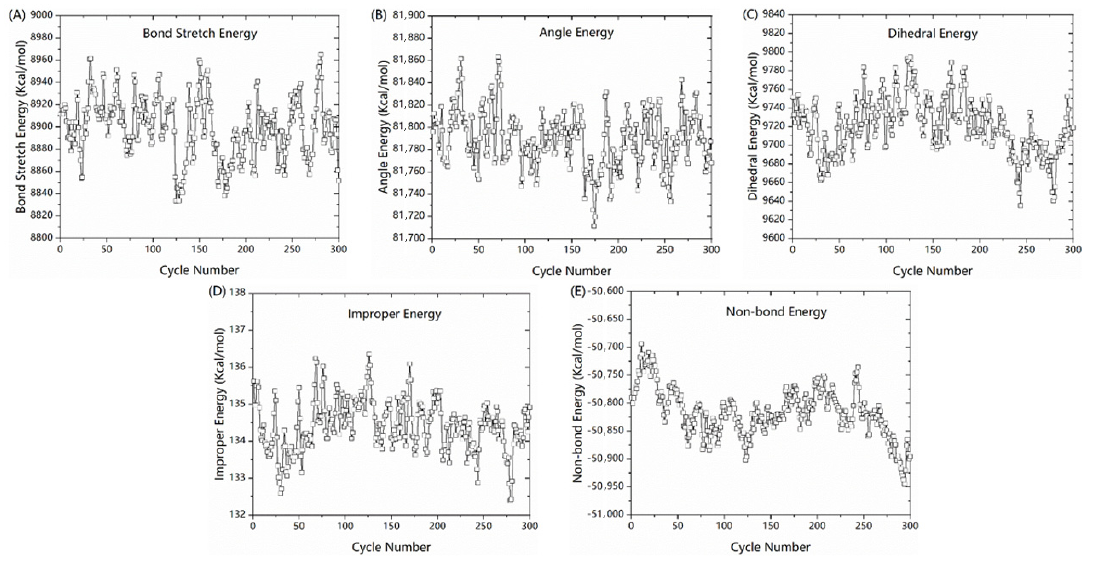
Figure 8. Evolution of individual potential energy in 90 ◦ direction. ( A ) bond stretch energy, ( B ) bond angle energy, ( C ) Figure 8. E volution of individual potential energy in 90° direction. ( A ) bond stretch energy, ( B ) bond angle energy, ( C ) diherdal energy, ( D ) improper energy, and ( E ) non-bond energy. dihedral energy, ( D ) improper energy, and ( E ) non-bond energy.